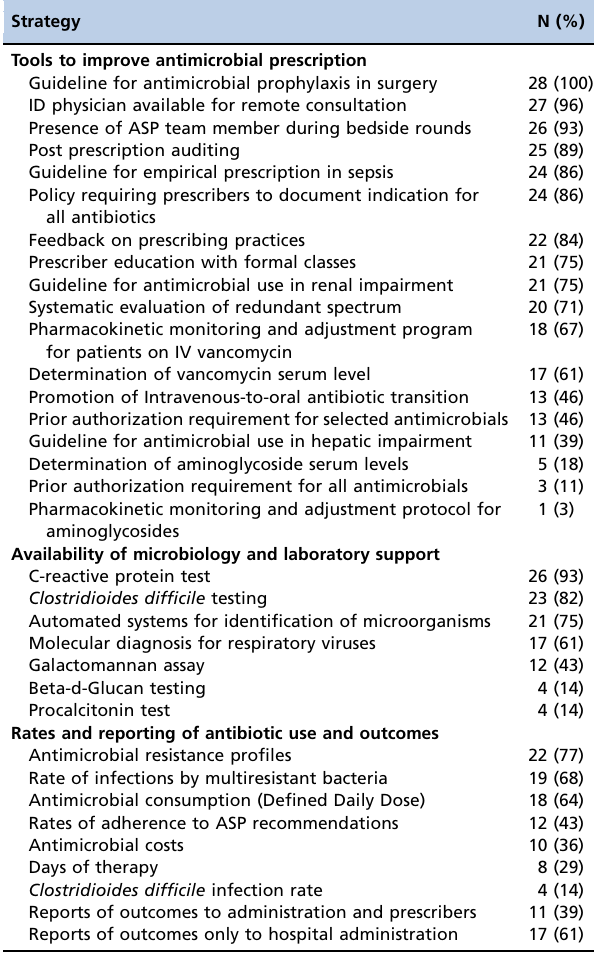
Table 1 - Description of the antimicrobial stewardship strategies, practices, and policies of 28 hospitals of the state of Sa˜o Paulo,